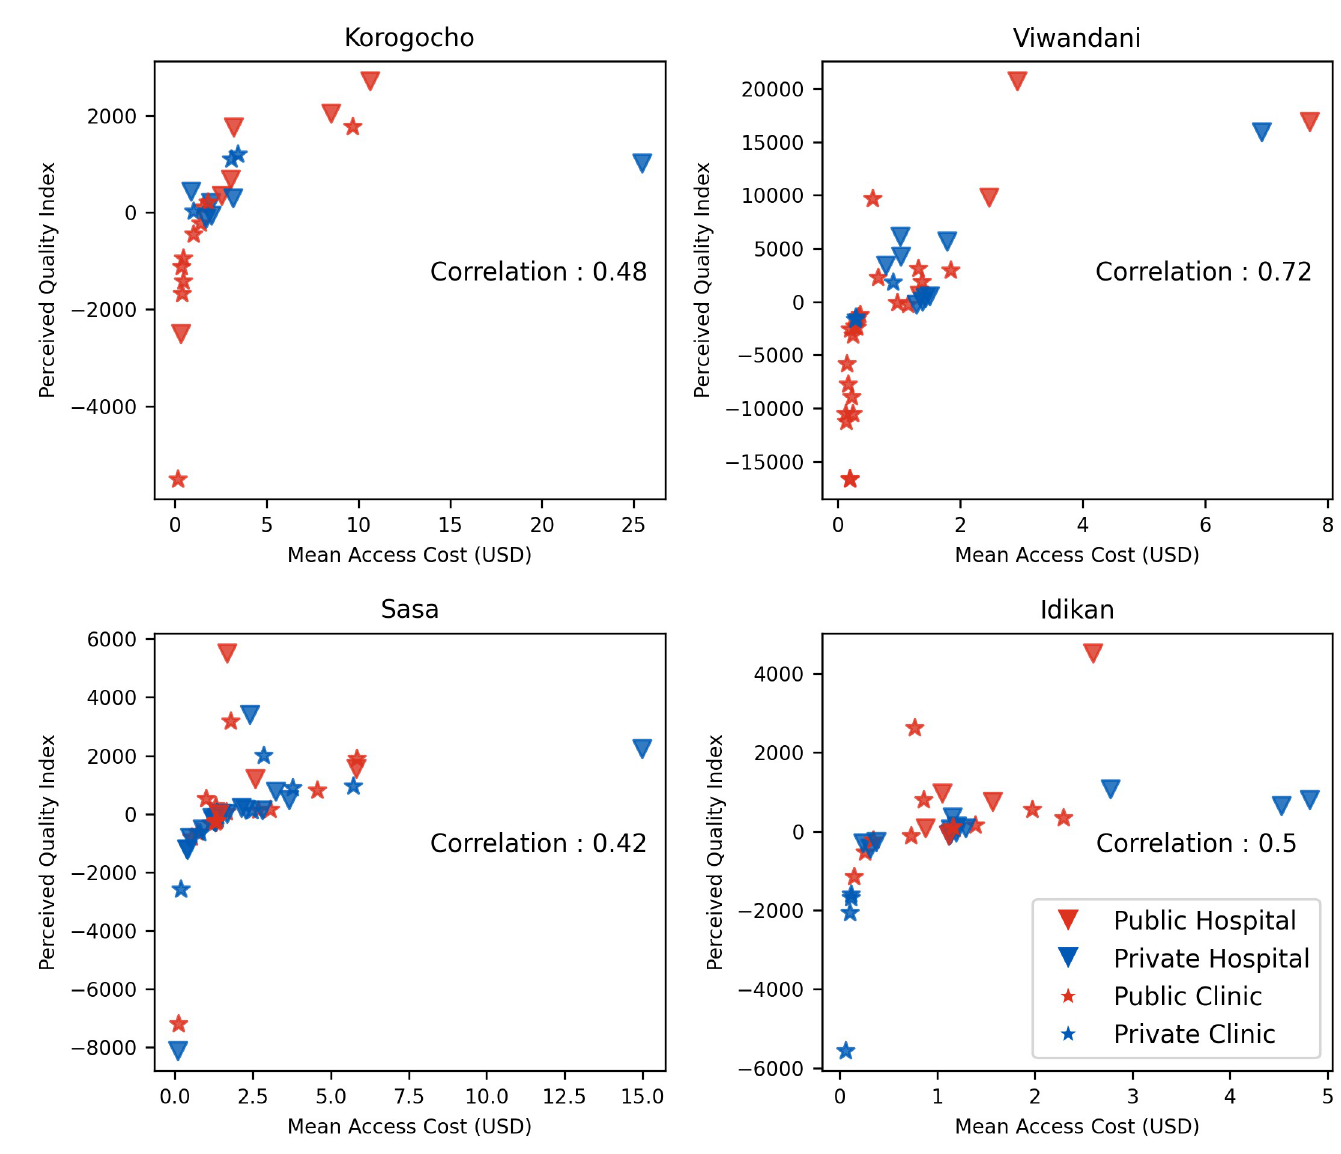
Fig 9. Scatter plot between attractiveness index and access cost with Pearson correlation